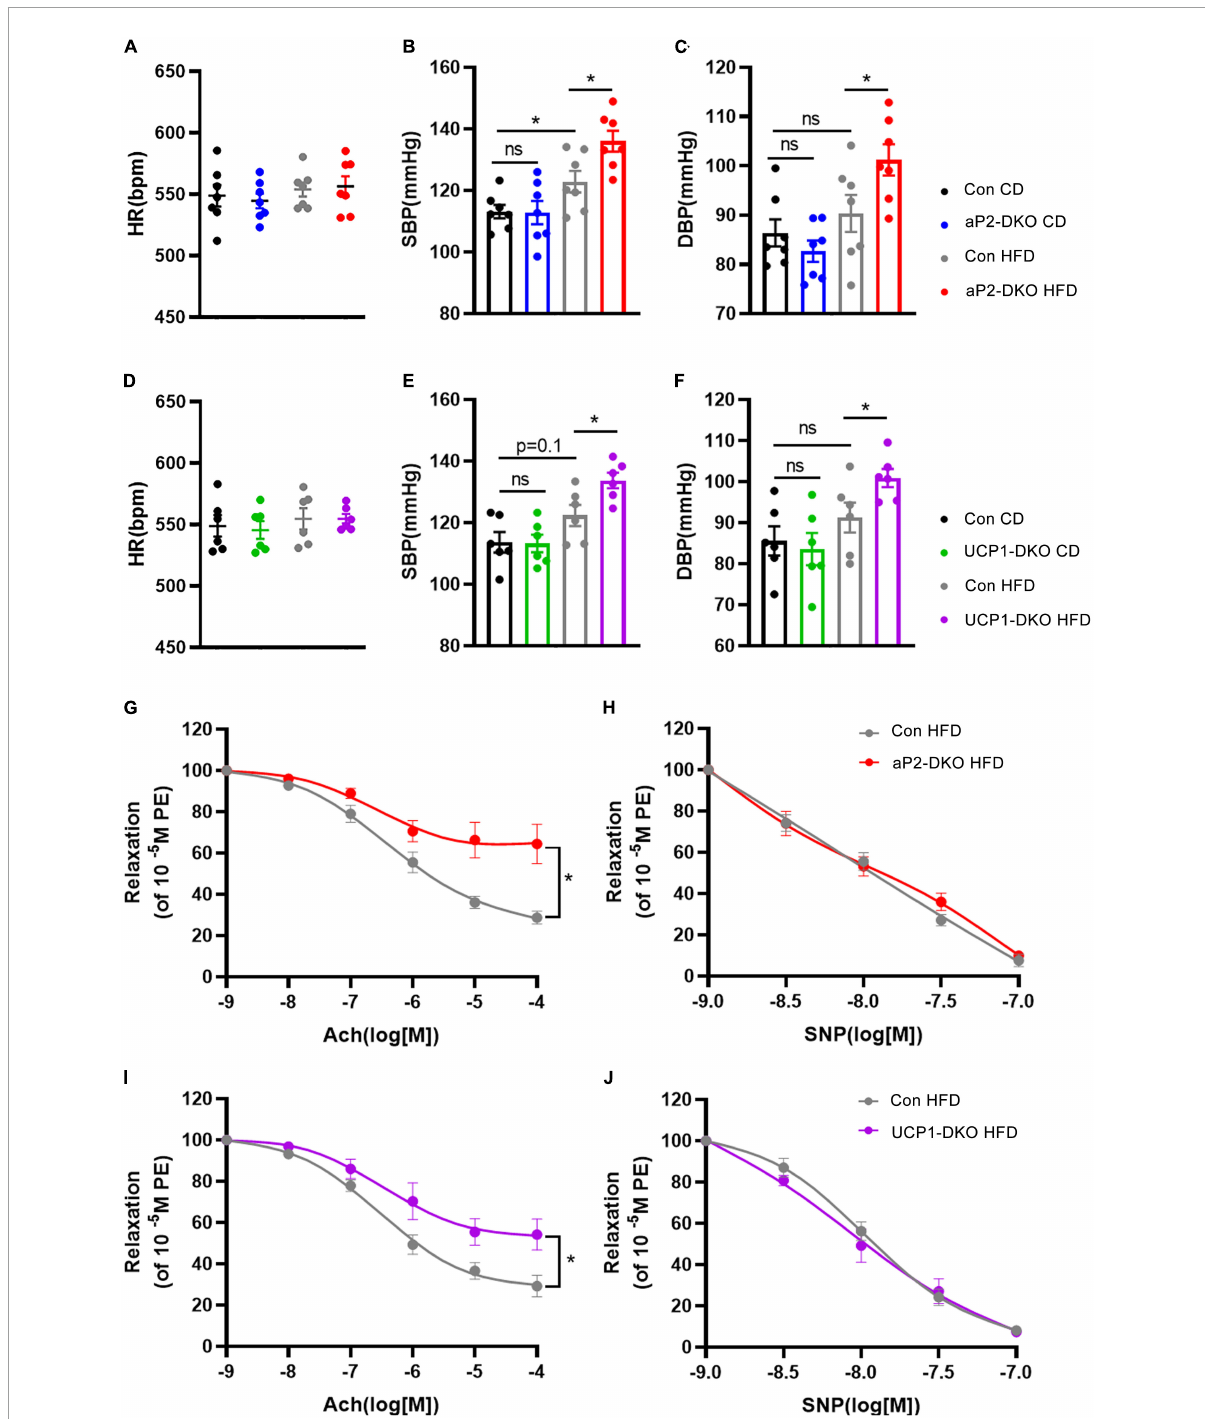
FIGURE1 Deficiency of bone morphogenetic protein 4 (BMP4) in perivascular adipose tissue (PVAT) aggravates HFD-induced hypertension. Male the control, aP2-DKO and UCP1-DKO mice were fed with HFD for 12 weeks. (A) Heart rate. (B) Average systolic blood pressure (SBP) and (C) diastolic blood pressure (DBP). (D) Heart rate. (E) Average SBP and (F) DBP. (G) Concentration-response curves of endothelium-dependent (ACh) relaxation. (H) Concentration-response curves of endothelium-independent (SNP) relaxation. (I) Concentration-response curves of endothelium-dependent (ACh) relaxation. (J) Concentration-response curves of endothelium-independent (SNP) relaxation. Values are means ± S.E.M. * P < 0.05, ** P < 0.01, and *** P < 0.001 by one-way analysis of variance (ANOVA) (A–F) or two-way analysis of variance (ANOVA) (G–J)